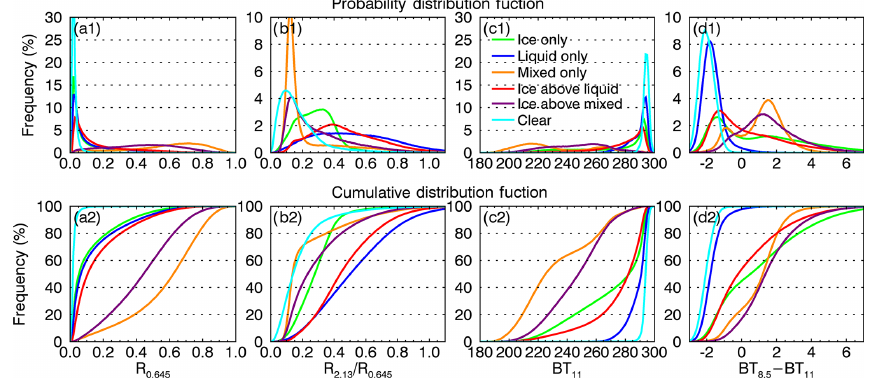
Figure 10. The annual PDFs and CDFs of reflectance at 0.645µm, reflectance ratio, BT at 11µm, and BTD between 8.5 and 11µm. The intervals for reflectance, reflectance ratio, BT, and BTD are 0.01, 0.01, 1, and 0.1K,